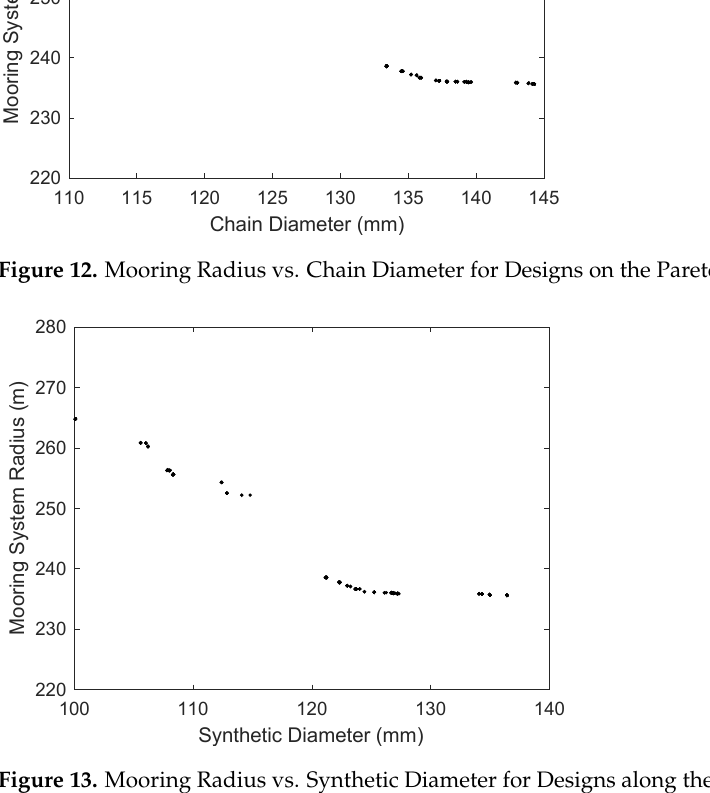
Figure 13. Mooring Radius vs. Synthetic Diameter for Designs along the Pareto-optimal Front.